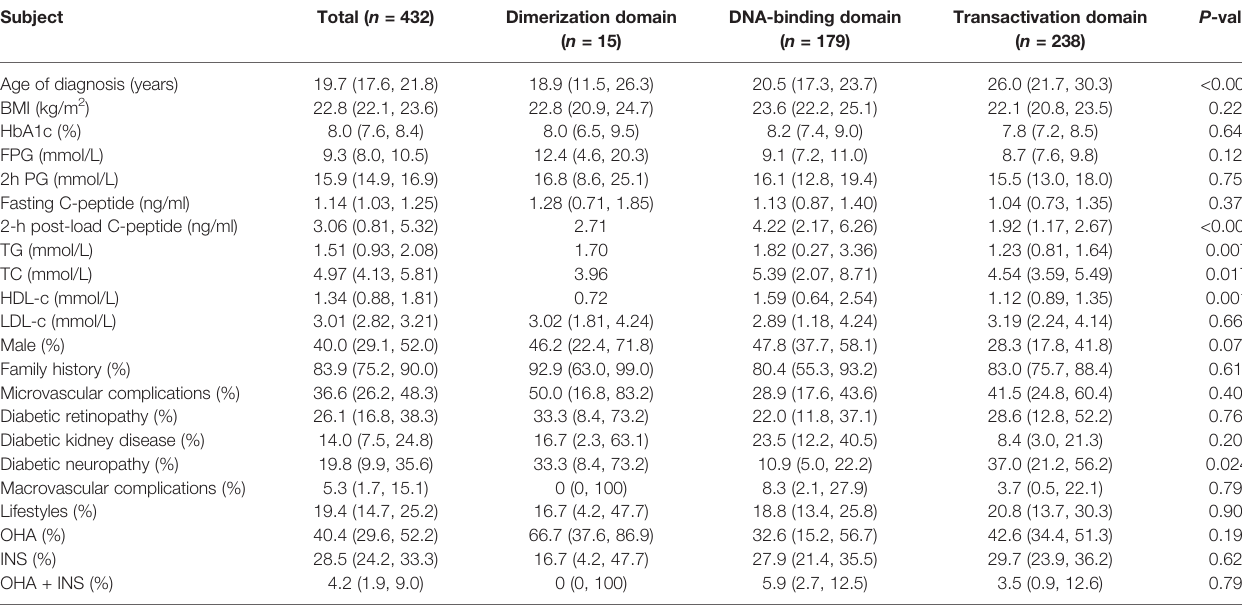
TABLE 2 | Characteristics of patients with HNF1-alpha MODY by genetic domains.